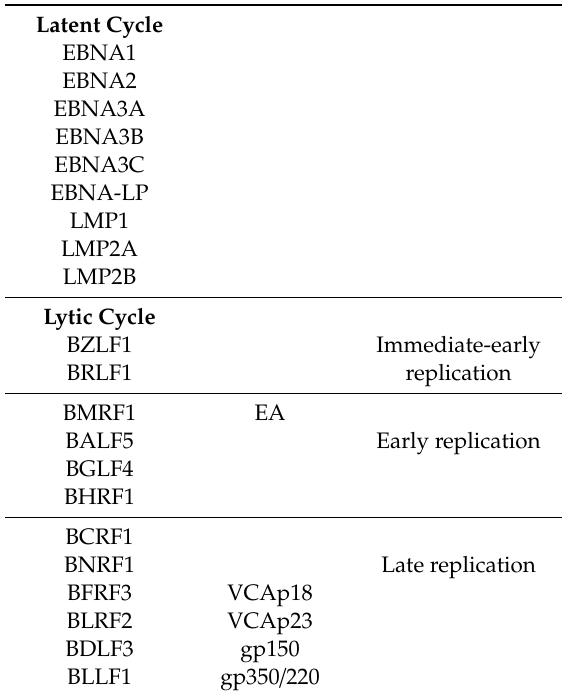
Table 1. Examples of EBV latent and lytic